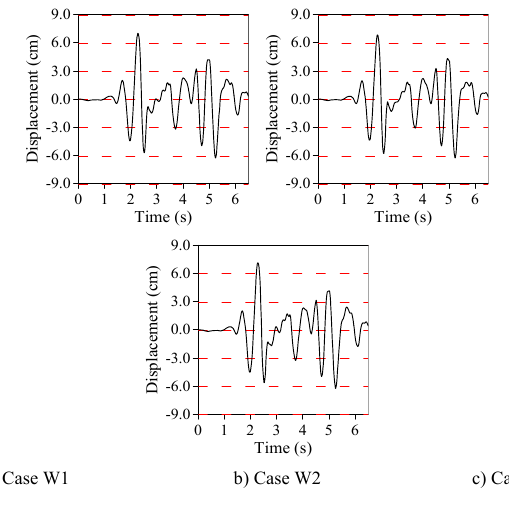
Fig. 17. The time histories of displacements at the nodal point 48 of arch dam for Case W. The variation of maximum and minimum principal stresses along I-I section (Fig. 4) are plotted in Fig. 18 for each case. It can be seen from Fig. 18 that the distribution of the